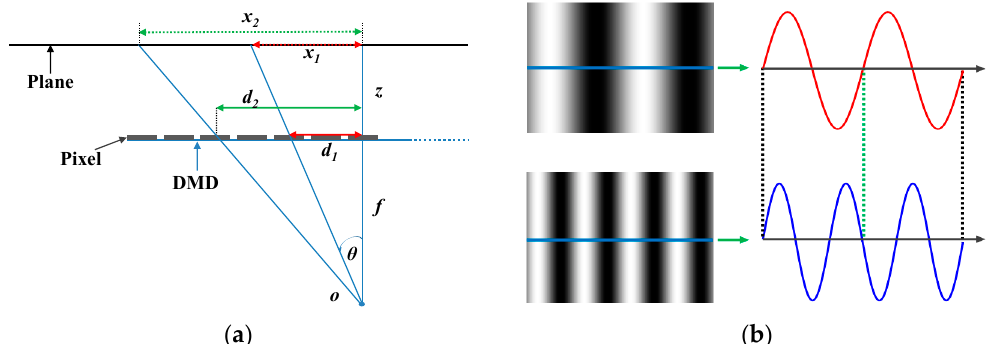
Figure 10. The DLP projector. ( a ) The projection geometry; ( b ) The upper and lower images on the left are projection patterns with the fringe frequency of two and four. The right images are a line of phase values corresponding to the blue line of the left image, respectively. The fringe boundary on the projection plane coincides with the fringe boundary on the DMD completely.